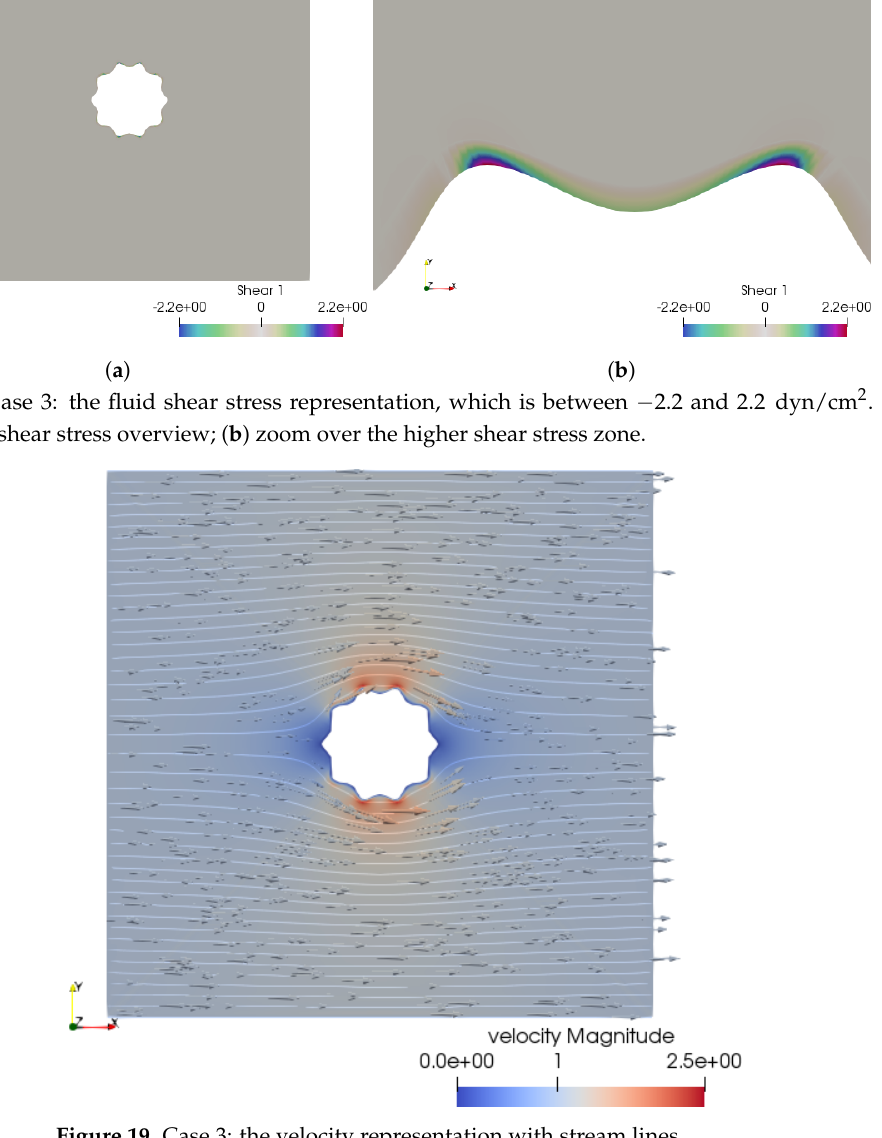
Figure 19. Case 3: the velocity representation with stream